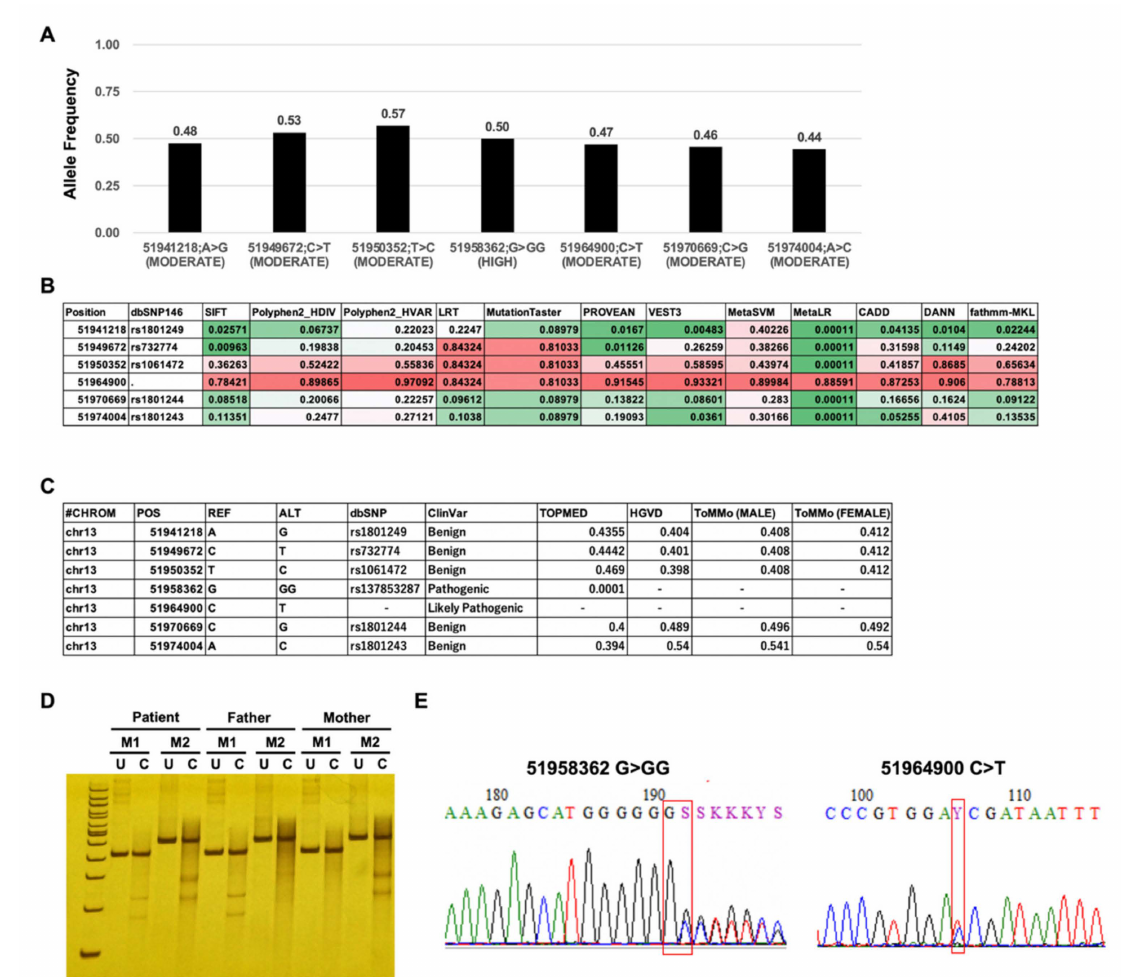
Figure 2. ( A ) Detection of haplotype mutations in the ATP7B locus. Allele frequency of variants; ( B ) In silico analysis of variants; ( C ) A summary of variants from the dbSNP, ClinVar, TOPMED, HGVD, and ToMMo databases; ( D ) Trio analysis by CHIPS technology assay (M1: chr13:51964900;C>T, M2: chr13:51958362;G>GG); ( E ) Patient electropherograms of the ATP7B mutations loci by Sanger